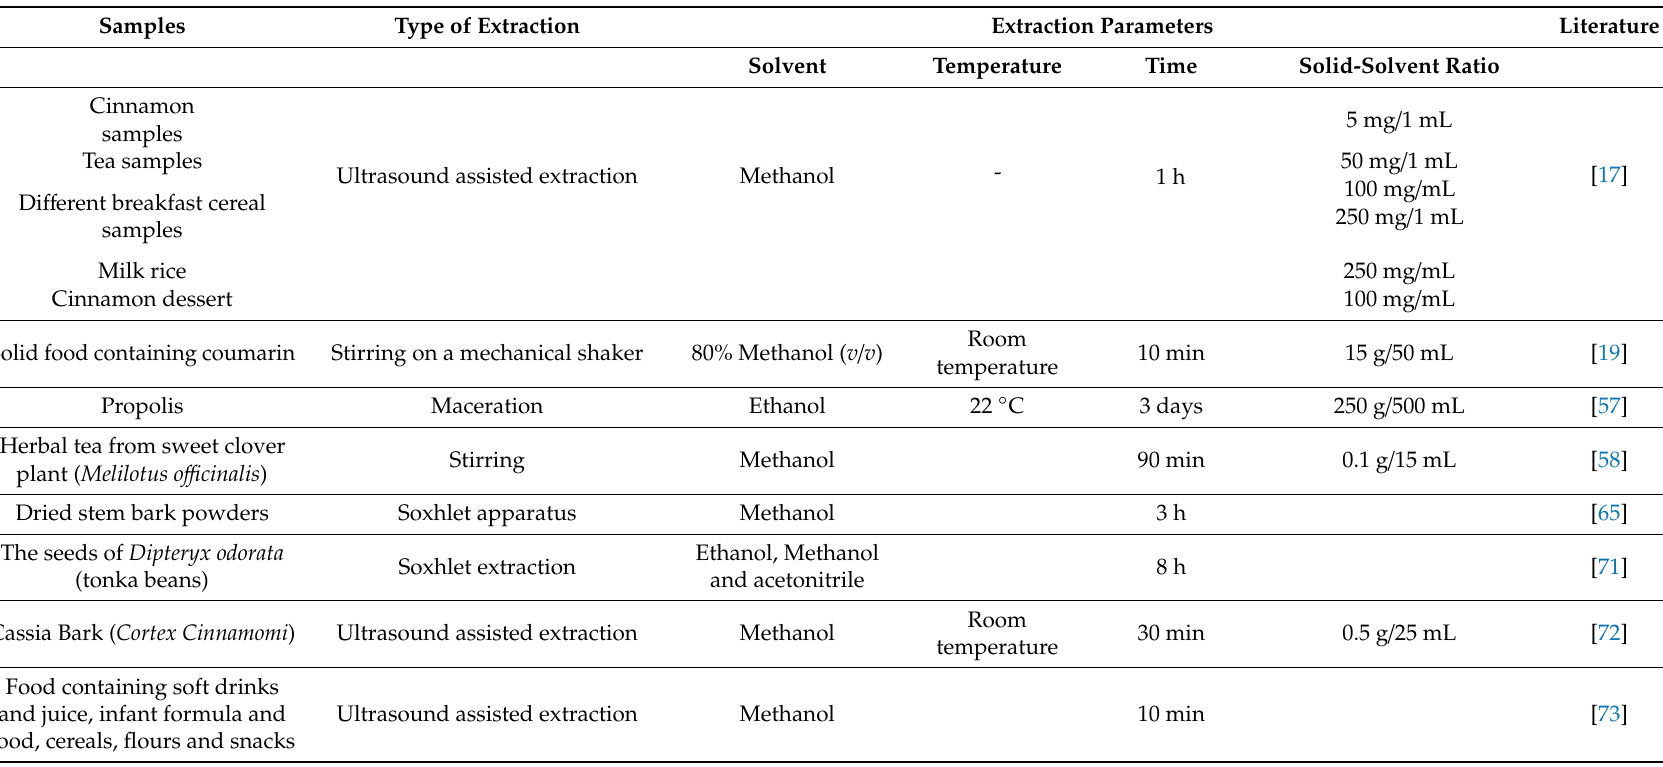
Table 5. Overview of extraction parameters for coumarin and related